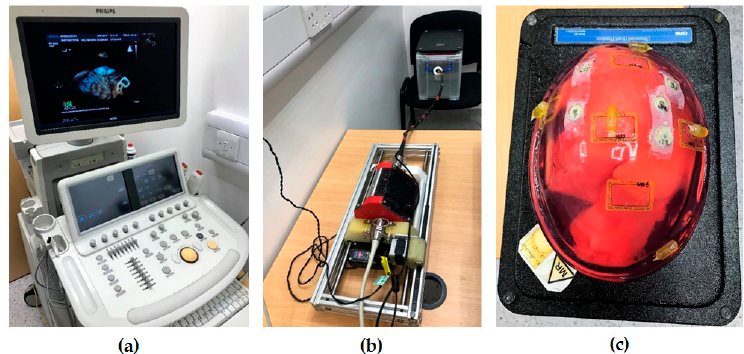
Figure 5. Experimental setup for the initialization step: ( a ) ultrasound machine; ( b ) TOE robot and the phantom setup; and ( c ) the heart phantom used for ultrasound imaging.